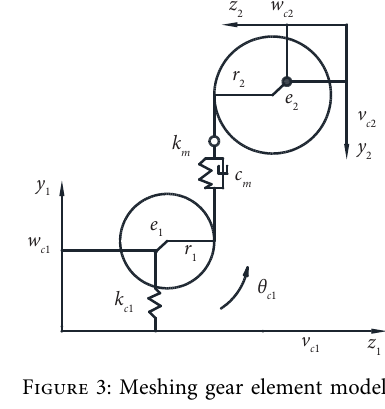
Figure 3: Meshing gear element model.